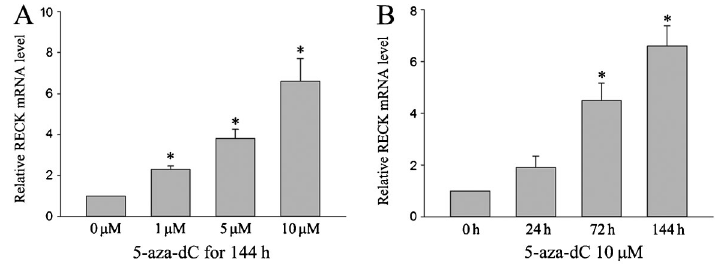
Figure 3. Relative mRNA expression levels of RECK gene by quantitative real-time PCR in ACC- M cell lines. 5-aza-2 9 deoxycytidine (5-aza-dC) enhanced RECK mRNA expression in a dose- and time-dependent manner. All expression levels are shown relative to the untreated sample. Data are reported as means±SD (n=3). *P , 0.05 compared with control (ANOVA).